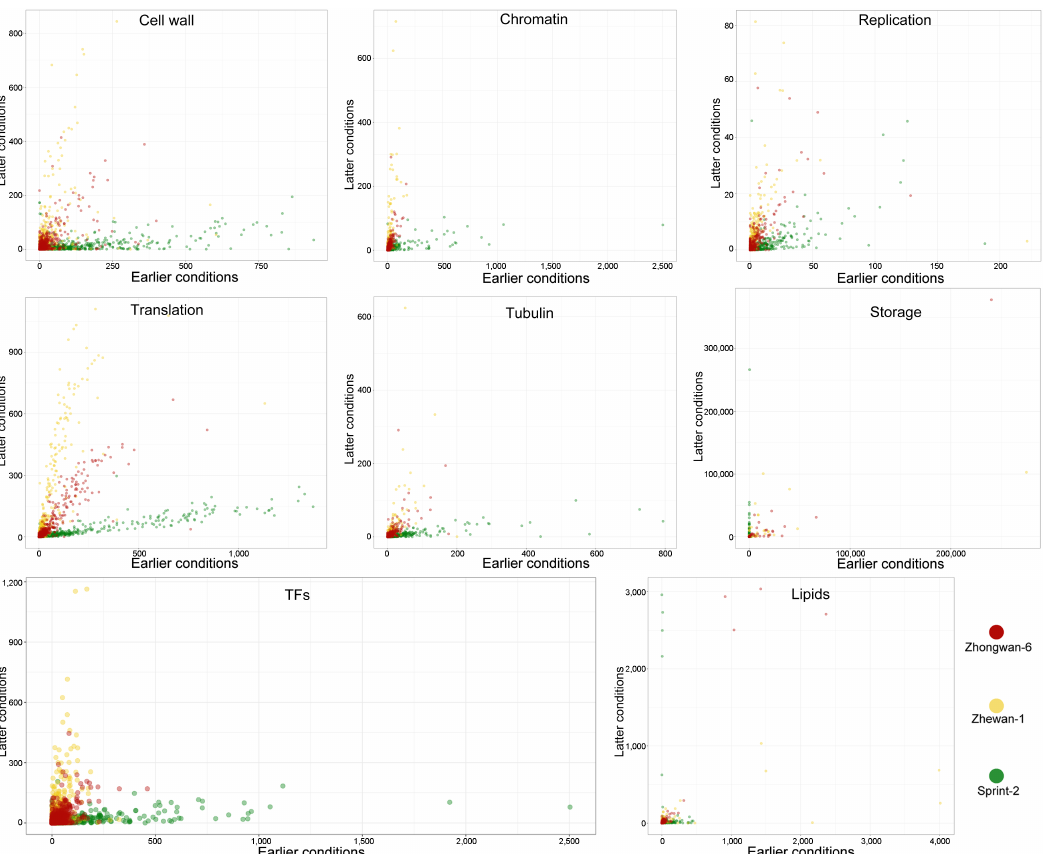
Figure 12. Term-wise scatterplots of early to late transcription dynamics in Sprint-2, Zhewan-1, and Zhongwan-6, where the x -axis denotes the mean expression at 10 DAP, and the y -axis denotes expression at a later (20 DAP for Sprint-2 and 25 DAP for Zhewan-1 and Zhongwan-6, respectively) stage. Transcripts belonging to the terms were selected according to the Gene Ontology annotation. For better visual interpretation, ‘Translation’ and ‘Cell wall’ scatterplots show only transcripts whose levels of expression do not exceed the indicated means; full images are presented in Figure